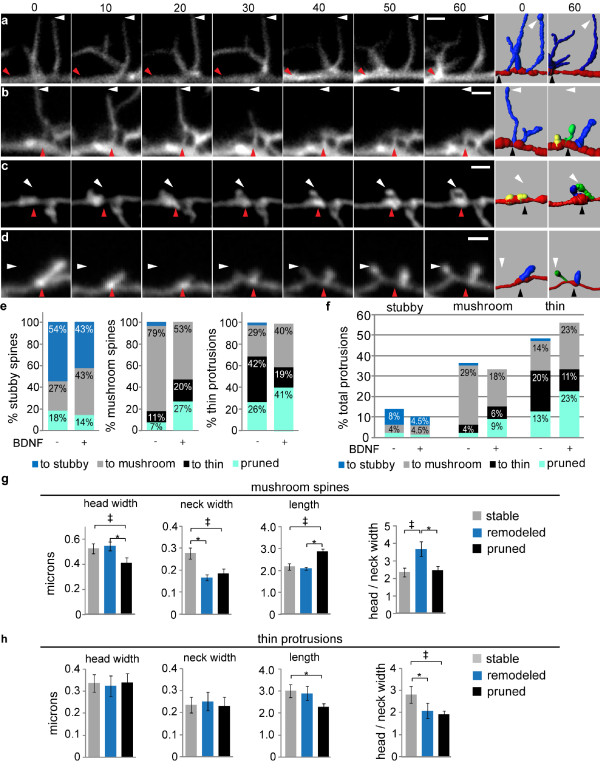
Acute BDNF induces specific types of spine remodeling. 12 DIV hippocampal neurons expressing Lifeact-ruby were treated with vehicle or 100 ng/ml BDNF and imaged at 5 min intervals for 1 hr. Each protrusion was classified as stubby, mushroom, or thin at t = 0 and 60 min. (a-d) At left, each each time series (0 - 60 min) depicts a representative type of dendritic protrusion remodeling observed during our analysis. At right, the automated 3D reconstructions illustrate the classification of each protrusion at t = 0 and 60 min (stubby: yellow, mushroom: green, thin: blue). (e) The diagram shows the percentages of pre-existing stubby, mushroom, and thin protrusions that were remodeled (to stubby, to mushroom, to thin) or pruned under control and BDNF-treated conditions. (f) Using the same dataset as in (e), we calculated the total incidence for each type of remodeling under control and BDNF-treated conditions. The histogram depicts the percentages of total protrusions that were initially stubby, mushroom, or thin and were either remodeled (to stubby, to mushroom, or to thin) or pruned. (g) The initial (t = 0) mean protrusion head width, neck width and length as well as the head width/neck width ratio were determined for mushrooms spines that were either stable (maintained mushroom morphology), remodeled into thin protrusions, or pruned within the 60 min imaging period following BDNF treatment (N = 24 - 32 spines; ANOVA, post-hoc Tukey's test; head width: ‡P = 0.032, *P = 0.017; neck width: *P = 0.020, ‡P = 0.037; length: ‡P = 0.032, *P = 0.017; head/neck ratio: *P = 0.002, ‡P = 0.001). (h) The group means listed above were determined for thin protrusions (t = 0) that were stable (maintained thin morphology), remodeled into mushroom spines, or pruned during 30 min. BDNF treatment (N = 36 - 47 spines; ANOVA, post-hoc Tukey's test; length: *P = 0.002; head/neck ratio: *P = 0.037).